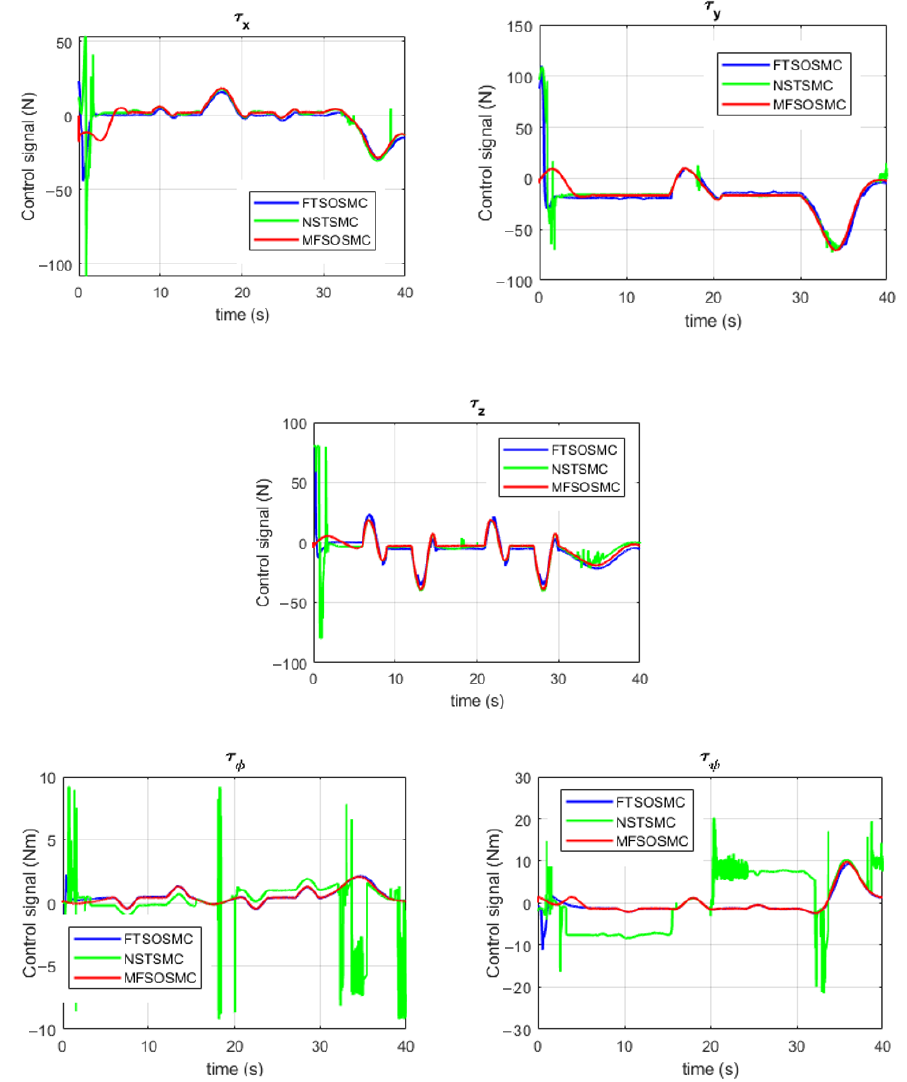
Figure 16. Control signals for UUV1 by all the controllers (with external disturbances).